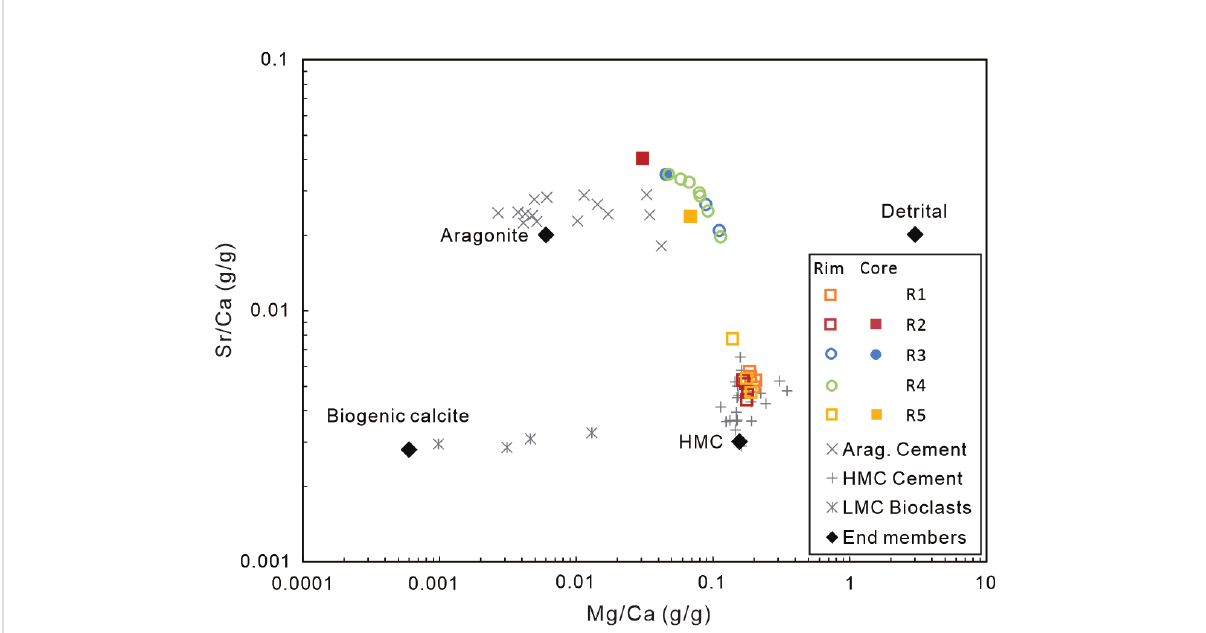
FIGURE 3 The relationship of Sr/Ca (g/g) vs. Mg/Ca (g/g) ratios re fl ects the composition of the mineral of the studied carbonates. The results of aragonite cement, HMC cement, and low magnesium calcite (LMC) reported by Joseph et al. (2013) are for comparison. The end members of Sr/Ca and Mg/Ca ratios of HMC, aragonite (Gong et al., 2018), and bioclastic and detrital fraction (Yang et al., 2014) are denoted in black